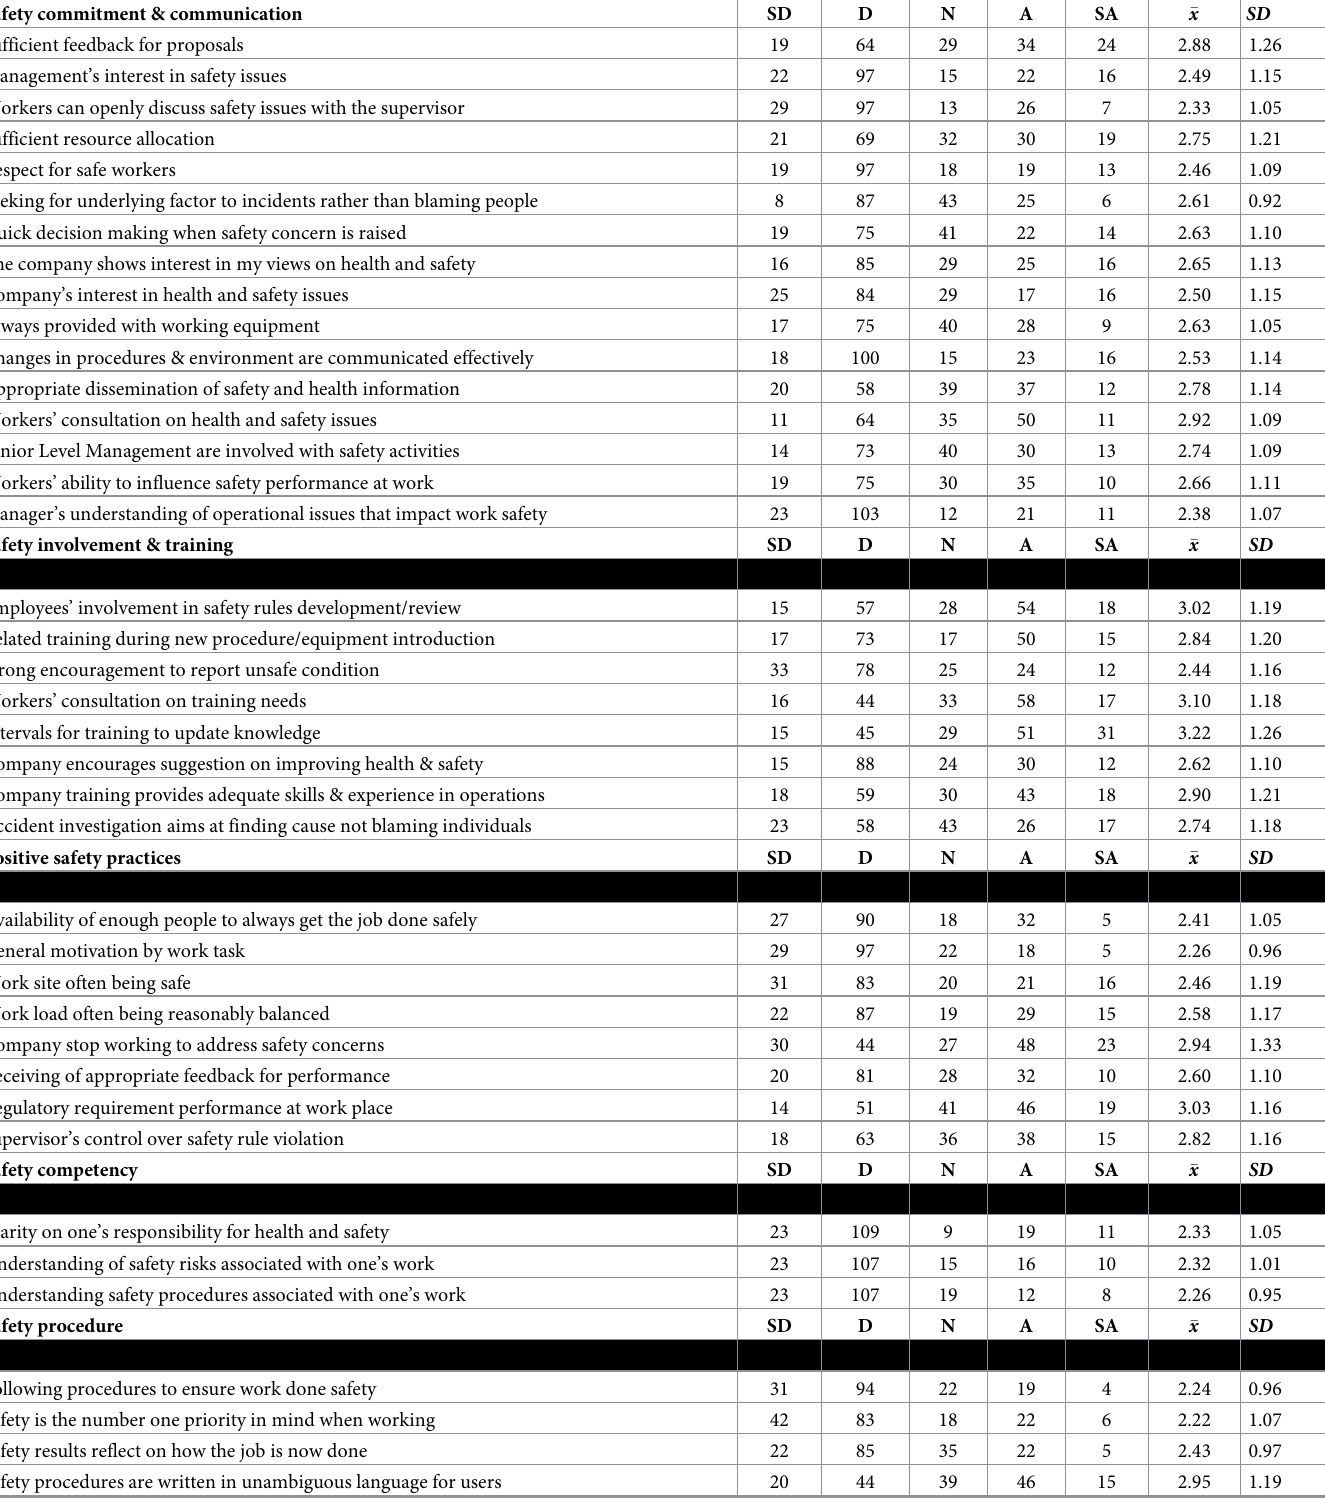
Table 4. The general safety climate of the Ghanaian printing